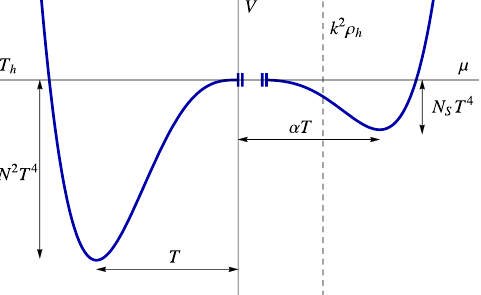
Figure 5 . Plot showing the parametric dependence of the potential in the AD model. The right hand side shows the radion potential at high temperature, with depth set by N s T 4 and width set by h µ i = α ( T ) T and the left hand side is the potential for the black hole hawking temperature T h , with width set by T and depth of order N 2 T 4 . The dashed line shows the would-be horizon position on the radion side of the potential and the break in the curve indicates the region where EFT control is